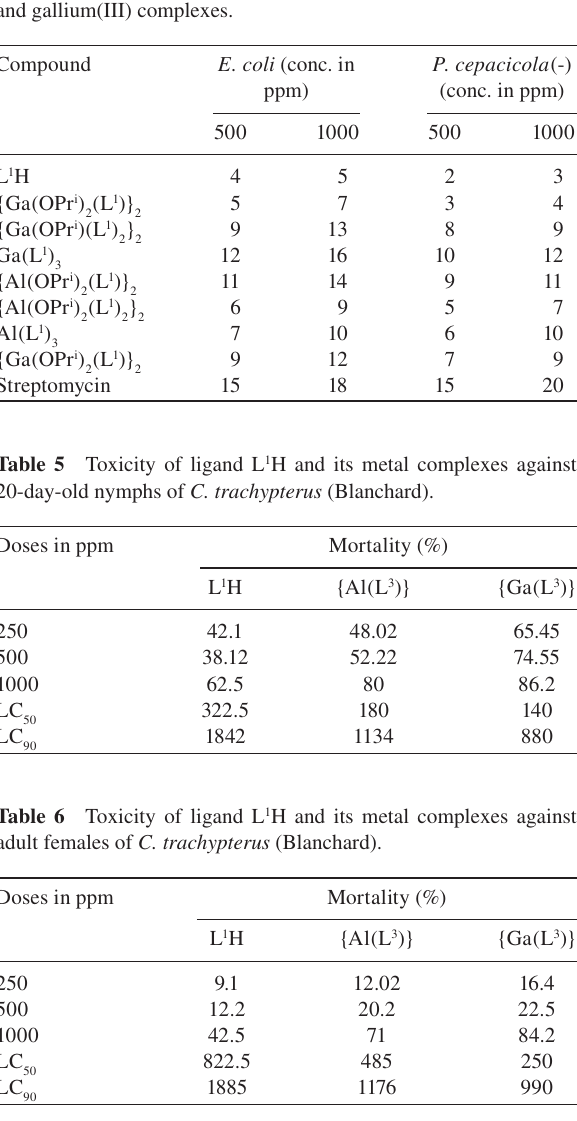
Table 4 Antibacterial screening data of L 1 H and its aluminum(III) and gallium(III) complexes.